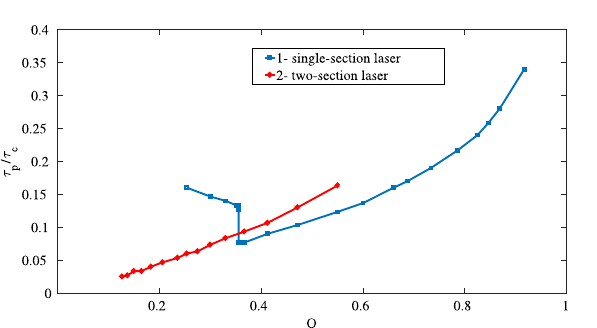
Figure 6. Examples of numerical solutions in regular mode-locking regime. ( a ) Intensity time trace A 3 14 the second threshold at N 0 = 0.17 · 10 cm − ; ( b ) A mode-locked regime with a single pulse in the cavity at N 0 = 0.45 · 10 14 cm − 3 ; ( c ) and ( d ) dependence of A 2 and A in the case of two coupled pulses per roundtrip at N 0 = 0.5 · 10 14 cm − 3 . This figure was created with Matlab R2018a (http://www.mathw orks.com).